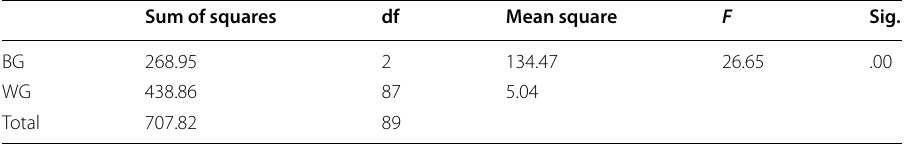
Table 4 Inferential statistics of speaking fluency posttest of all groups Sum of squares